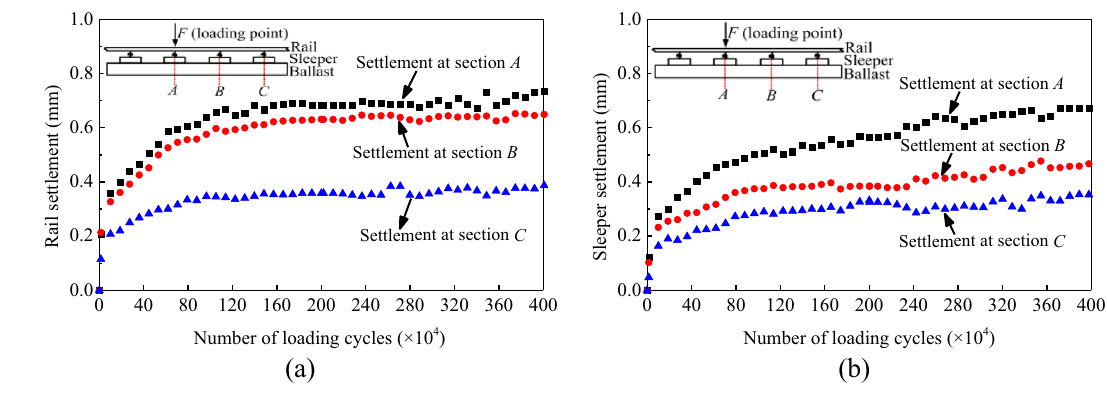
Fig. 22 Accumulative settlement of the ballasted track: a rail settlement; b sleeper settlement